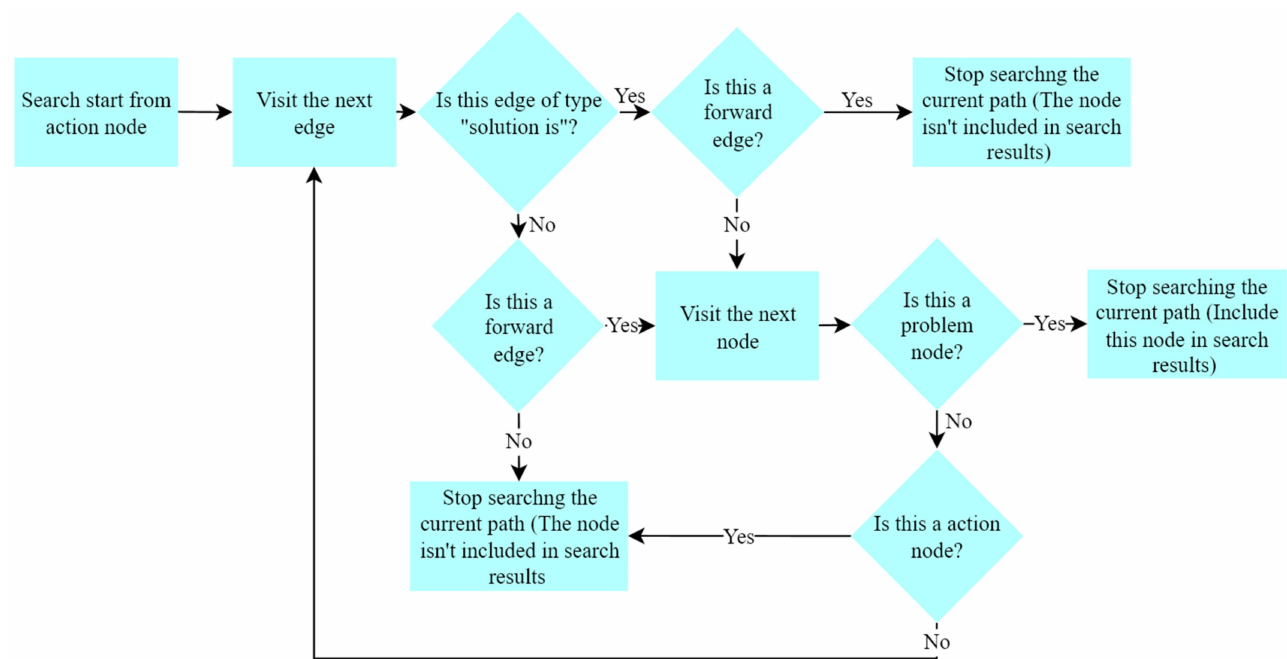
Figure 10. Action node search